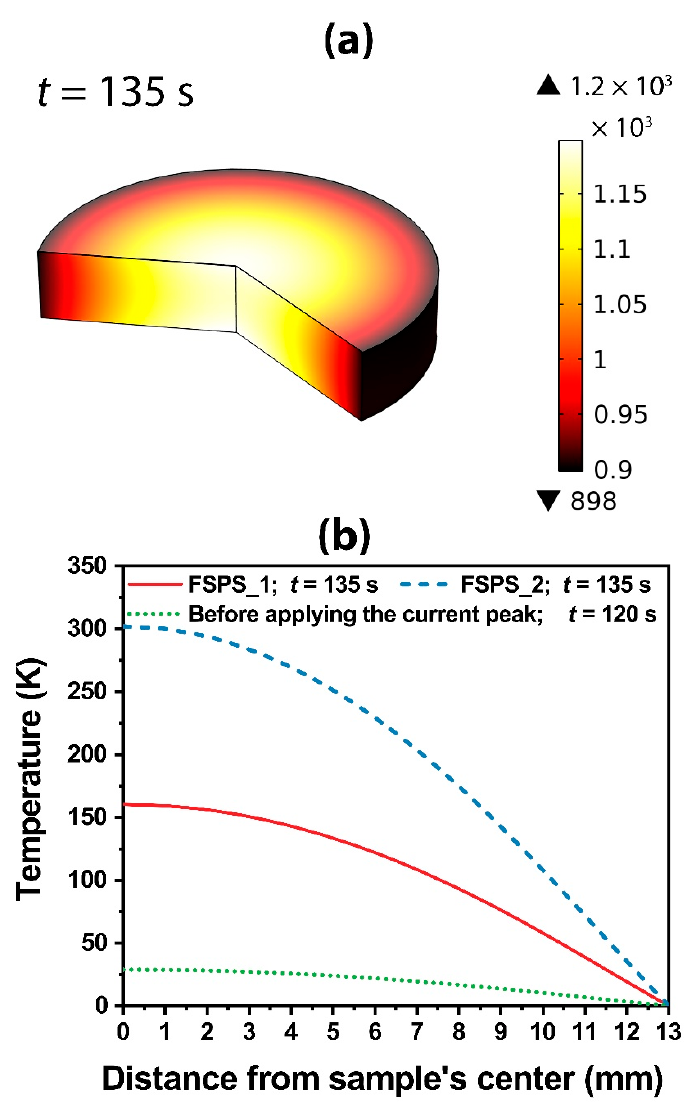
Figure 7. ( a ) Temperature distribution (K) inside FSPS_2 at the end of the experiment ( t = 135 s); ( b ) temperature difference from the edge for both samples, before and at the end of applying high current amplitude ( t = 120 and 135 s, respectively).